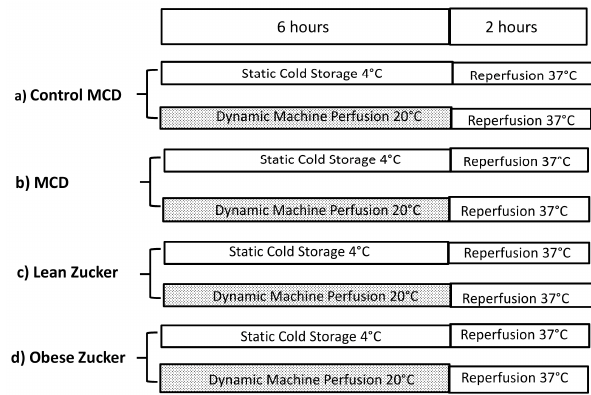
Figure 4. The overall experimental protocol we adopted using fatty livers and their respective controls. Wistar rats were fed with either MCD diet for two weeks ( b ) or control isocaloric diet added with methionine and choline ( a ); obese Zucker rats 11–12 weeks old (fa/fa) ( d ) and lean male Zucker rats ( c ) were used ( n = 7/group).